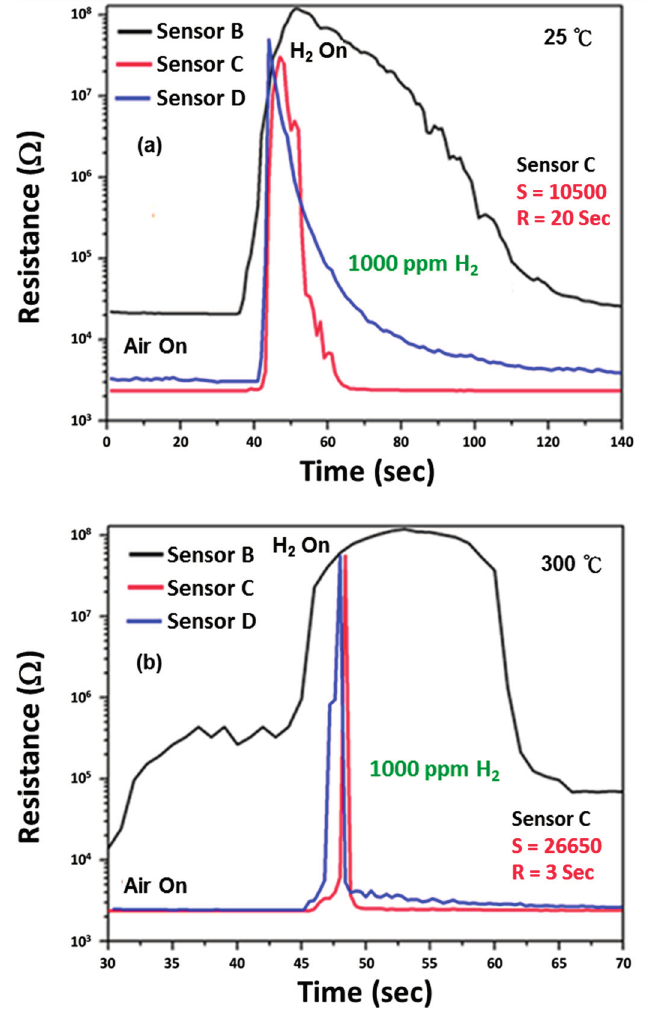
Figure 4. Change in resistance of SnO 2 gas sensors with different Pt loading concentrations upon exposure to 1000 ppm of H 2 gas at an operating temperature of ( a ) 25 °C and ( b ) 300